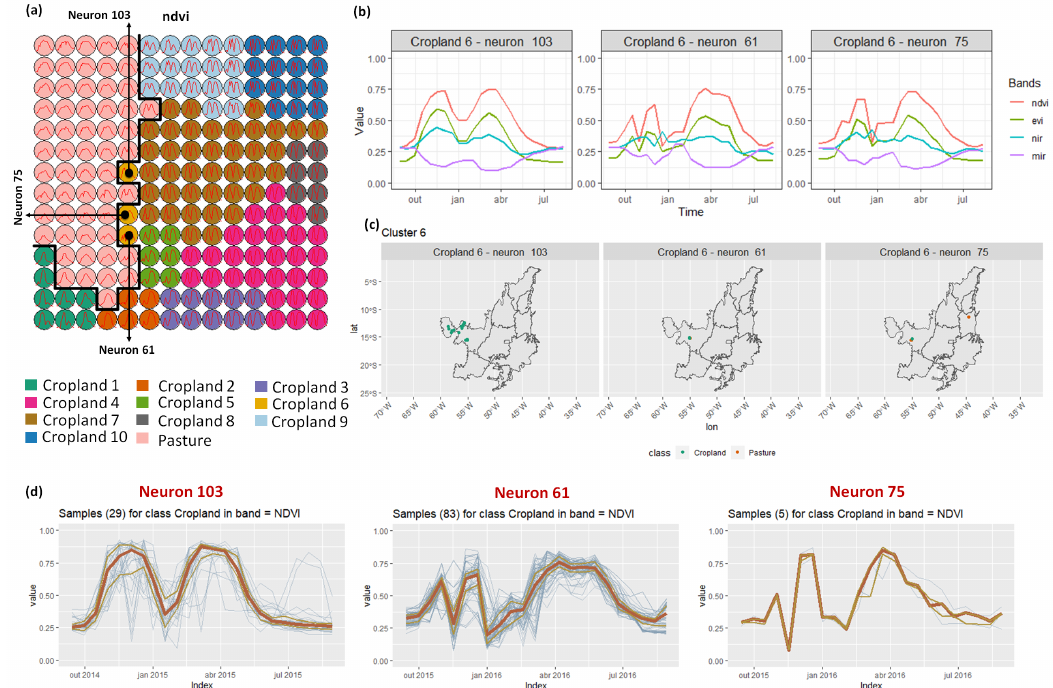
Figure 11. Cluster of Cropland 6 ( a ) SOM grid. ( b ) Weight vectors of neurons that belong to Cropland 6. ( c ) Spatial location where the samples allocated by neurons 103, 61, and 75 are. ( d ) NDVI time series and the number of samples by assigned to these neurons of Cropland 6. The blue line are the raw NDVI time series, the thick line is the median, and the yellow lines represent the 25% and 75%